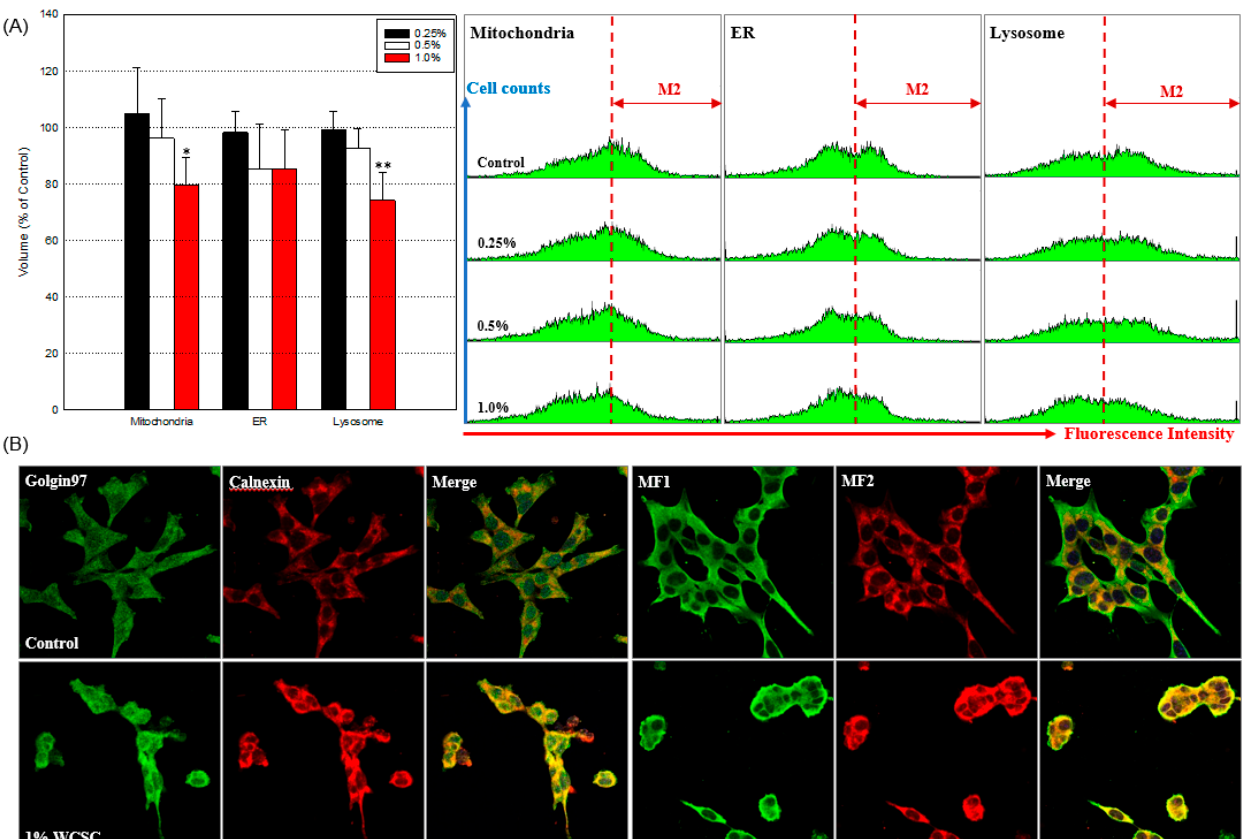
Figure 4. Structural damage of organelles. After 24 h exposure, astrocytes were incubated with indicators that can label each organelle: ( A ) percentages of cells in M2 zone (the increased volume). Overall, 10,000 cells per sample were analyzed using a FACS system, and the levels were calculated as the relative value compared to control (100%). The graphs on the right show the representative results. Data indicate mean ± SD of independent three experiments. * p < 0.05, ** p < 0.01; ( B ) cells were reacted with indicators for trans-Golgi (golgin97) and ER (calnexin) (left) or mitochondrial fission-related proteins (MF1 and MF2) overnight at 4 °C. Magnification: ×400.